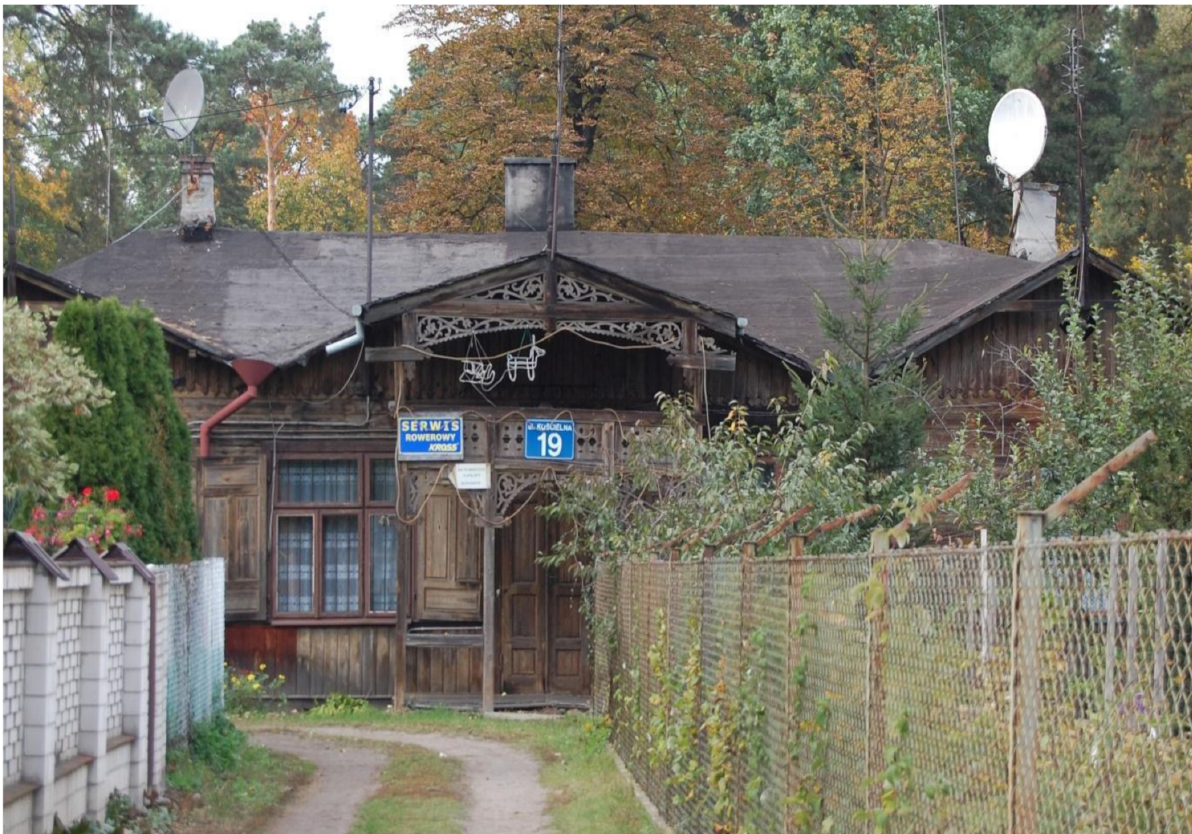
Figure 6. Otwock, Ko´scielna Street 19, Odo Bujwid villa, Stefan Szyller (1888); photo: W. Lach, 2011. In the buildings occurring in Western summer resorts and in the Alps, erected in the Swiss style due to the availability of material, the main body is made of stone or brick. In German, Galician and Silesian boarding houses, cloister or balcony terraces usually surround the building on the side of the gable wall, hidden under the overhang of the wide gable eaves, protruding considerably behind the wall face. Additionally, this part of the building is oriented in the south or south-west direction. Leisure villas on the banks of